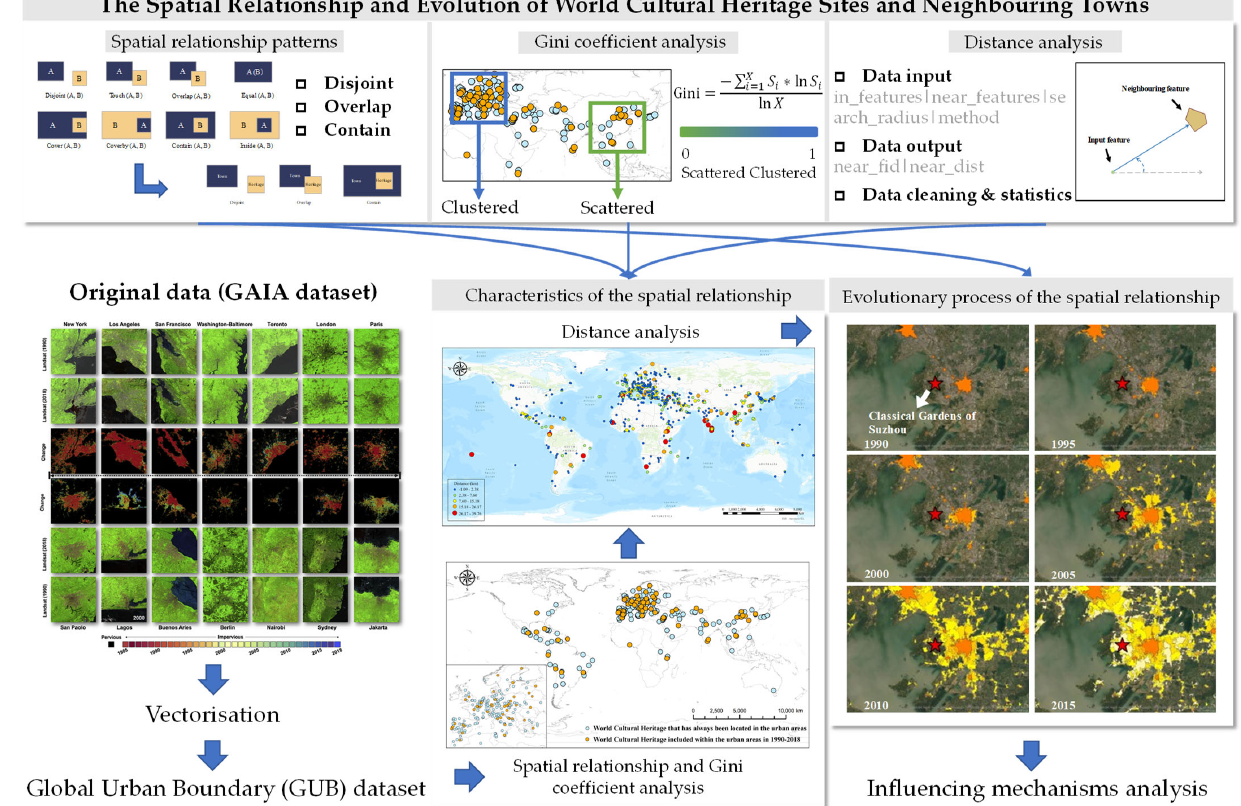
Figure 1. Flow diagram of the methods used in this study.